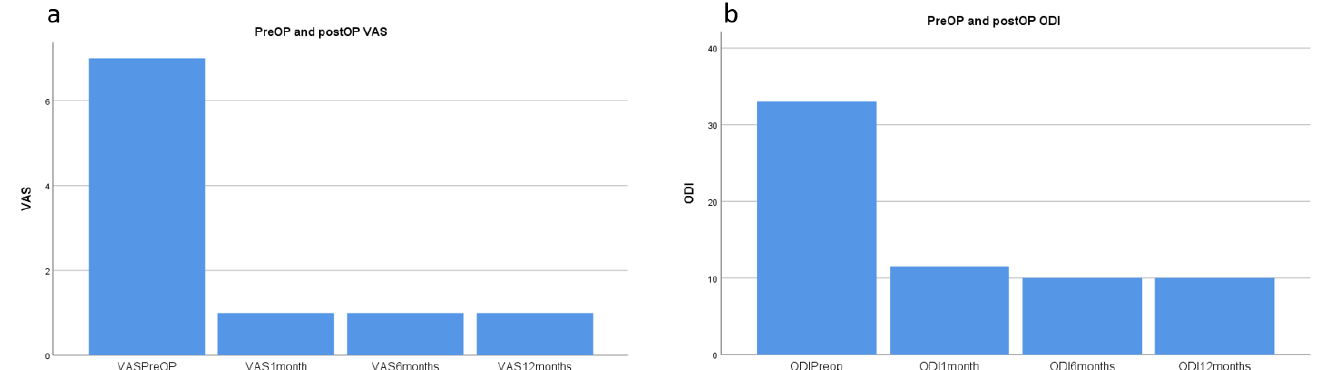
Figure 4. VAS and ODI scores before and after the surgery ( a ) Median VAS score improved from 7 (6–8) to 1 (0–3) after surgery. ( b ) Median ODI score improved from 33 (25–48) to 10 (5–22) after surgery. VAS: visual analog scale. ODI: Oswestry Disability Index. Table 1. Summary of the patients and their treatment results.